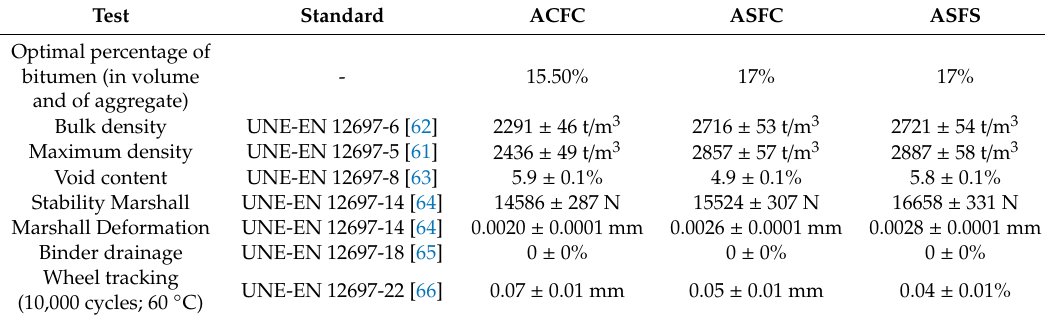
Table 10. Test results for the optimal combination of materials of the di ff erent families of bituminous mixtures ACFC, ASFC and